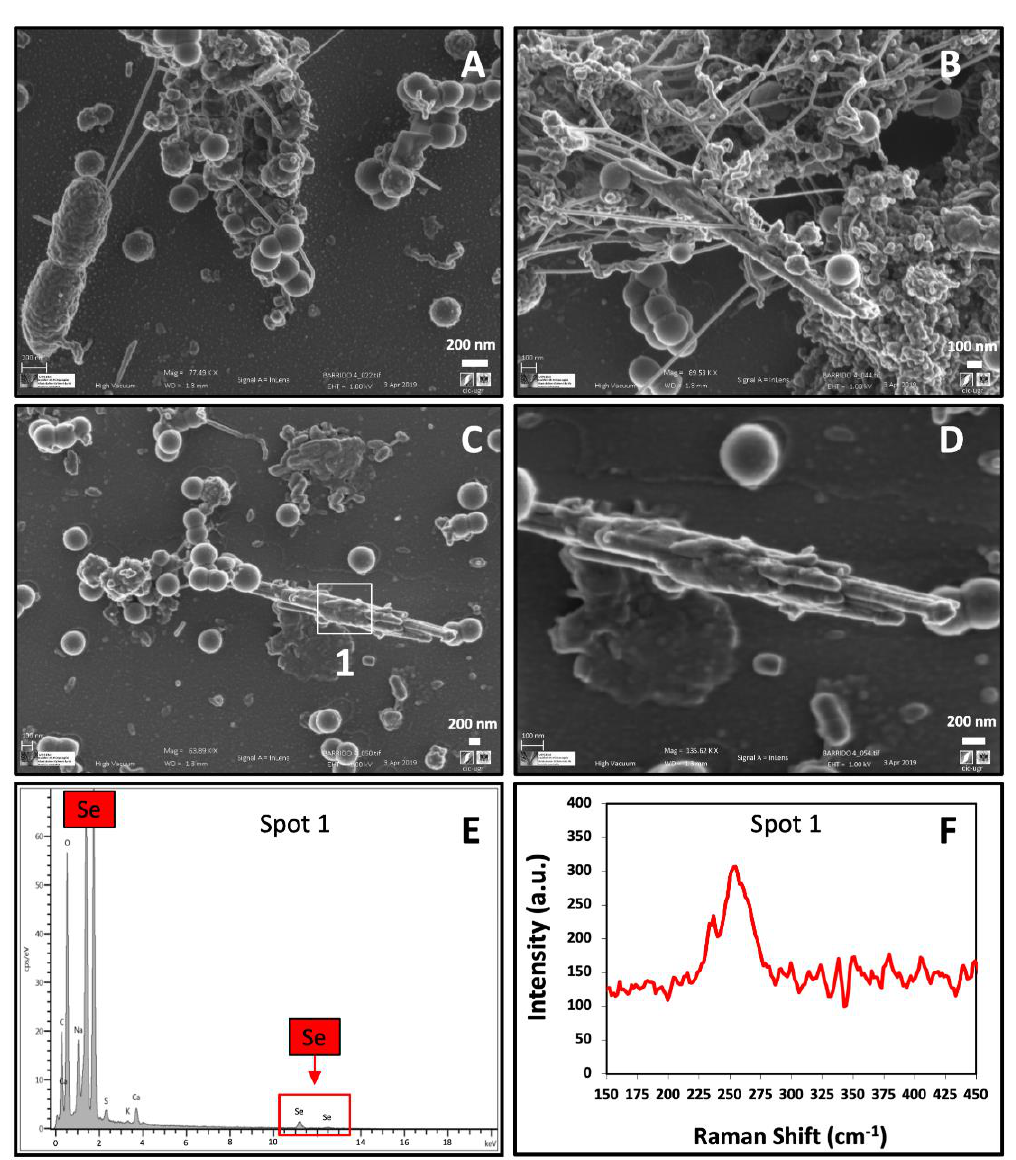
Figure 7. VP-FESEM micrographs showing SeNPs associated with organic materials and filaments ( A , B ) and Se nanowires within the extracellular space ( C , D ) under anaerobic conditions at an initial pH of 10. EDX analysis of an individual nanowire indicates its Se composition ( E ). Raman scattering spectrum derived from the same nanowire ( F ). Scale bars: 200 nm ( A , C , D ) and 100 nm ( B ).